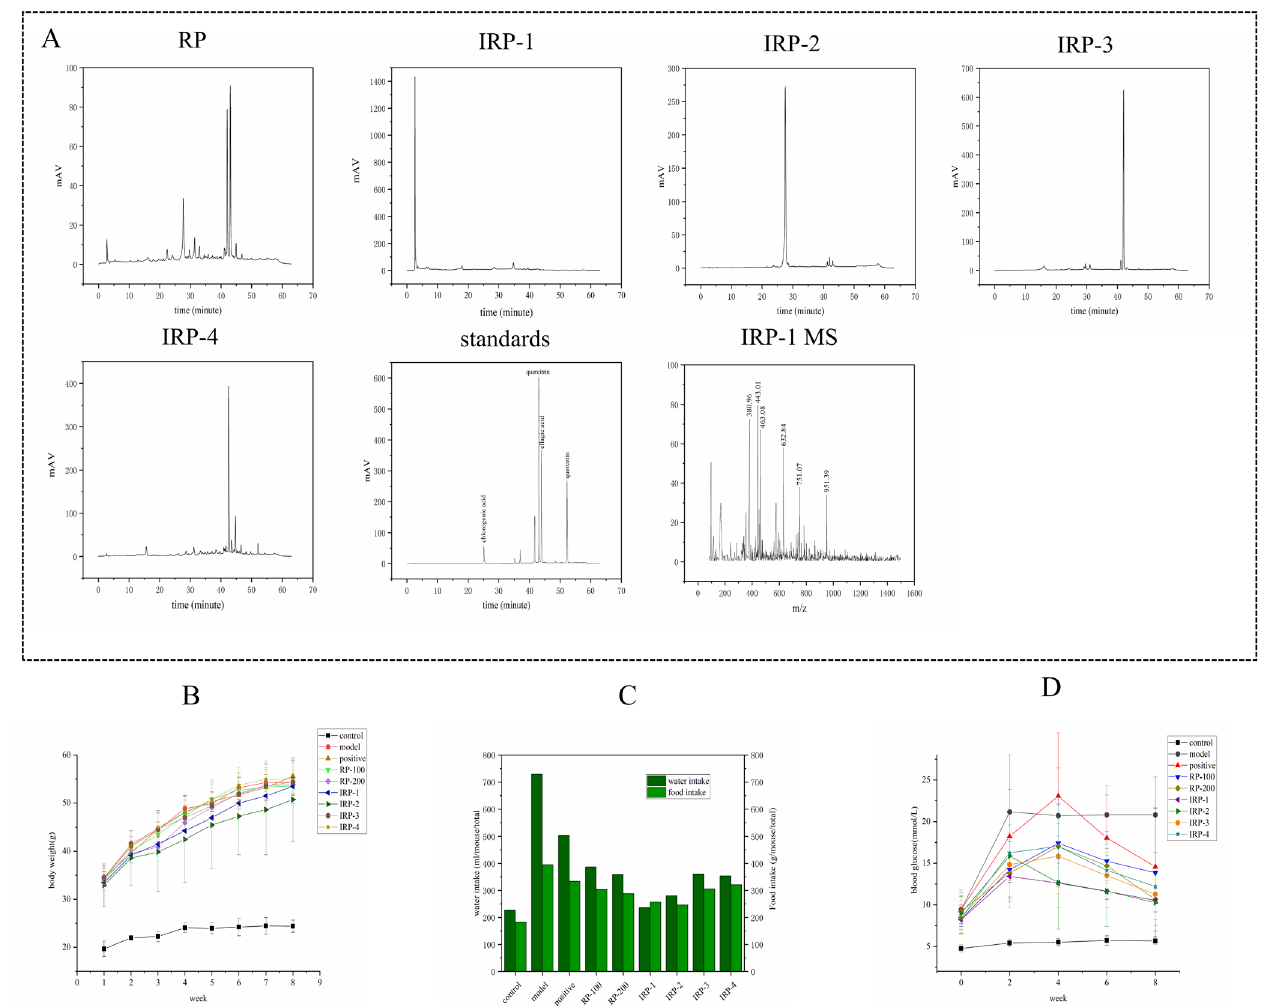
Figure 1. HPLC analysis of RP, IRP 1–4, standard reference samples, and effects of RP and IRP 1–4 on weight, food and water intake, FBG in db/db mice of 0 and 8 weeks. ( A ) HPLC of total phenolic compounds (RP) in RRT and the 4 main components isolated from RP. Effects of RP and IRP 1–4 on the body weight ( B ), food intake and water intake ( C ), and fasting blood glucose ( D ) in the db/db mice. All data are presented as the means ± SD ( n = 6) except food and water intake.